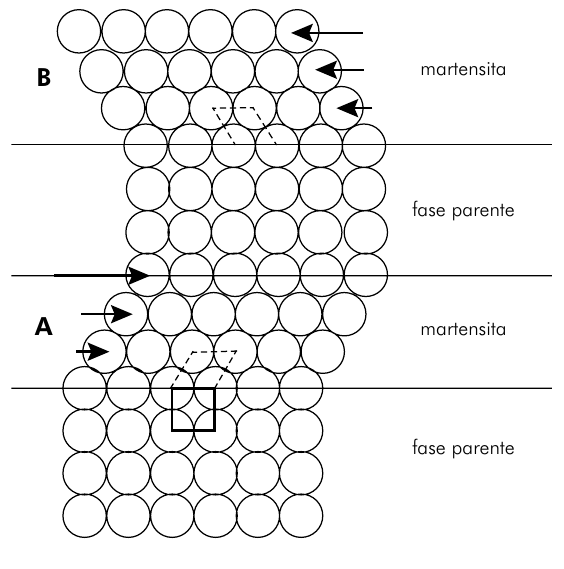
Figure 1. Simplified model of martensitic transformation according to Otsuka and Wayman.